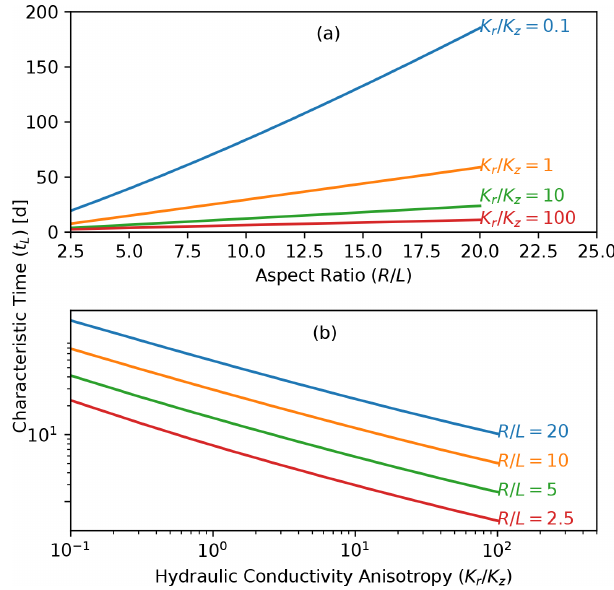
Figure 9. Characteristic time as a function of (a) polygon as- pect ratio and (b) anisotropy coefficient. The K r /K z = 1 line in plot (a) corresponds to characteristic times in Fig. 8b. Note that the trends in (a) are nearly linear and on naturally scaled axes, while the trends in (b) are also nearly linear on log-transformed